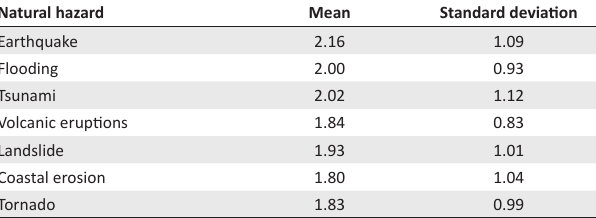
TABLE 6: Descriptive mean summary of readiness for natural hazards.